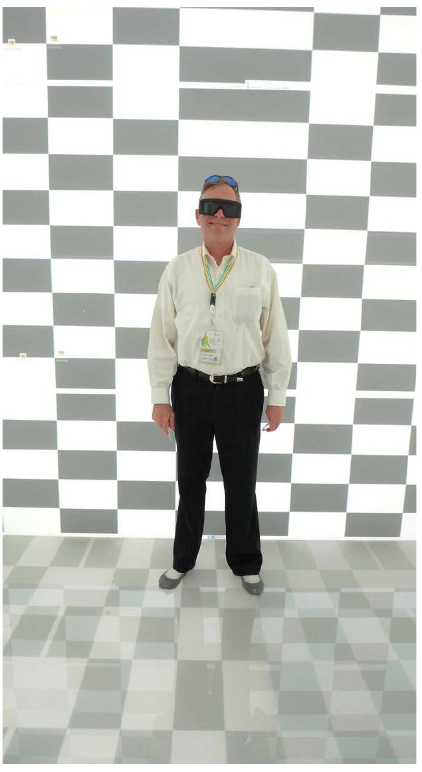
Figure 16. KAUST Cornea checkerboard pattern. Photo: Dan Sandin.